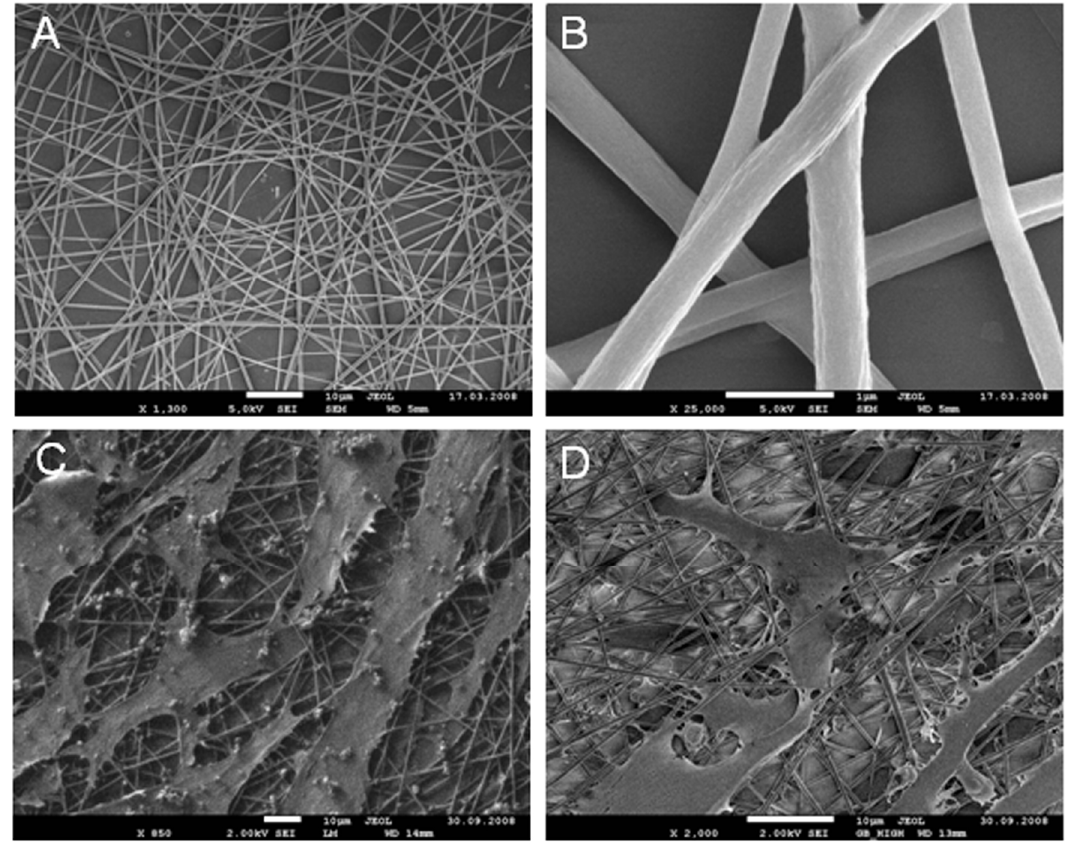
FIGURE 1. Characterization of PLLA-COLI blend. SEM analysis of a PLLA-COLI (1:1) blend (A,B). Same fibers after cell culture over a period of 22 days in growth medium (C) and differentiation medium